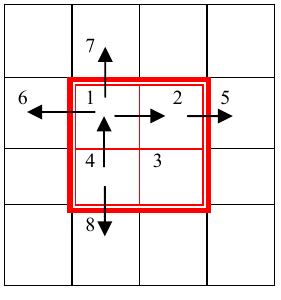
Figure 6. The basic idea of the LOQ measure.